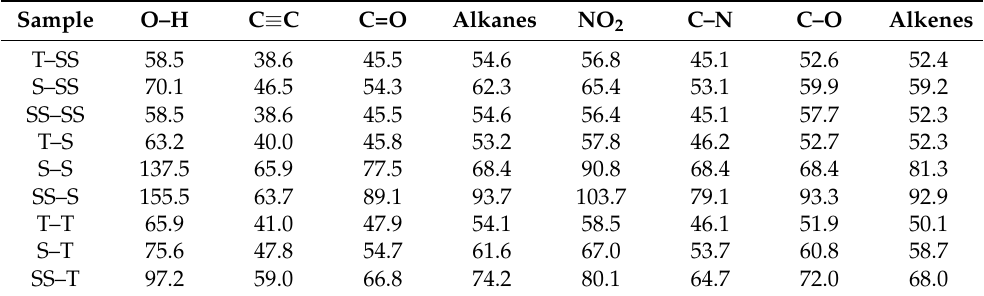
Table 4. Functional groups and % transmittance of activated